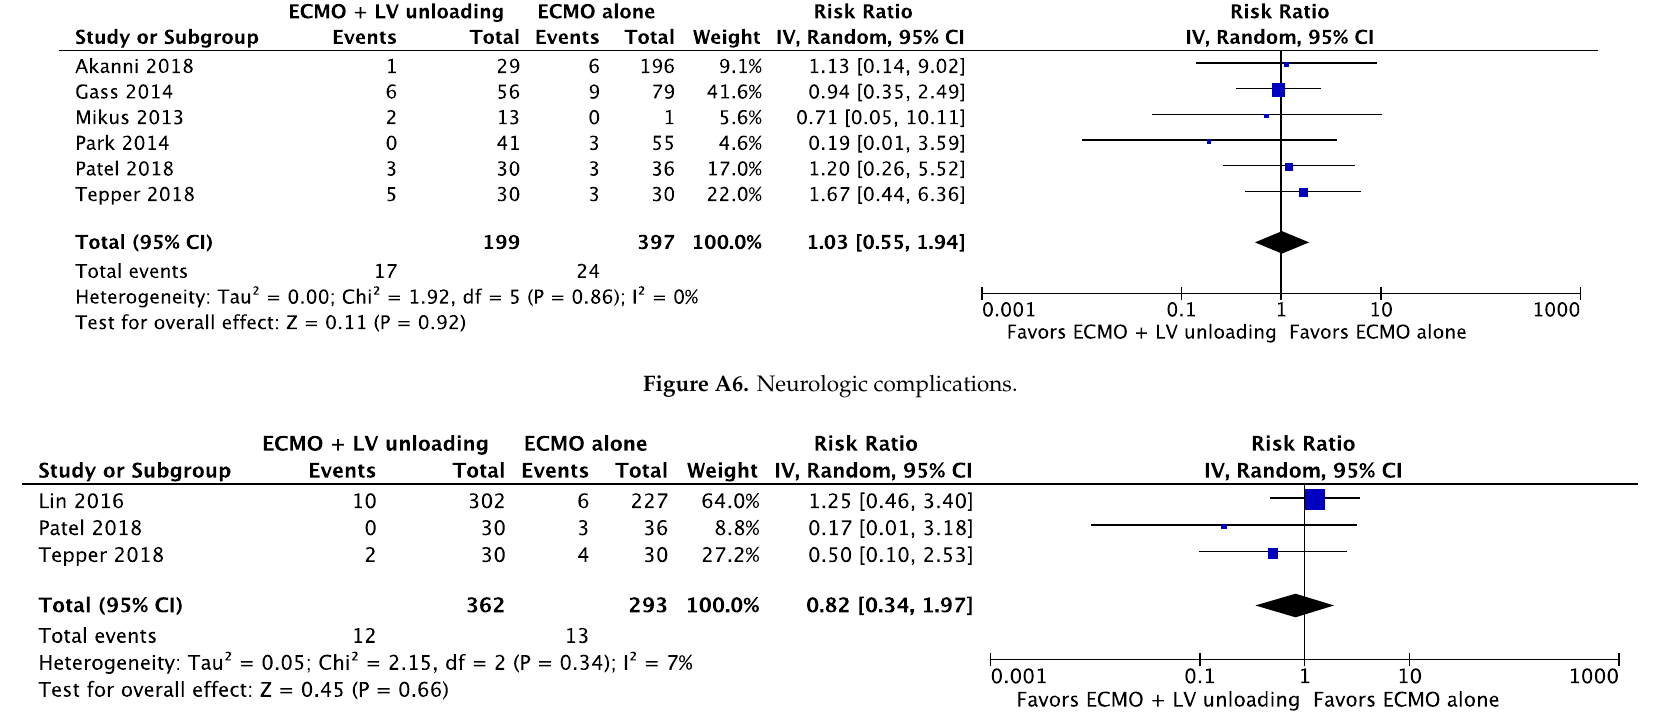
Figure A7. Brain Figure A7. Brain death. Figure A7. Brain death.